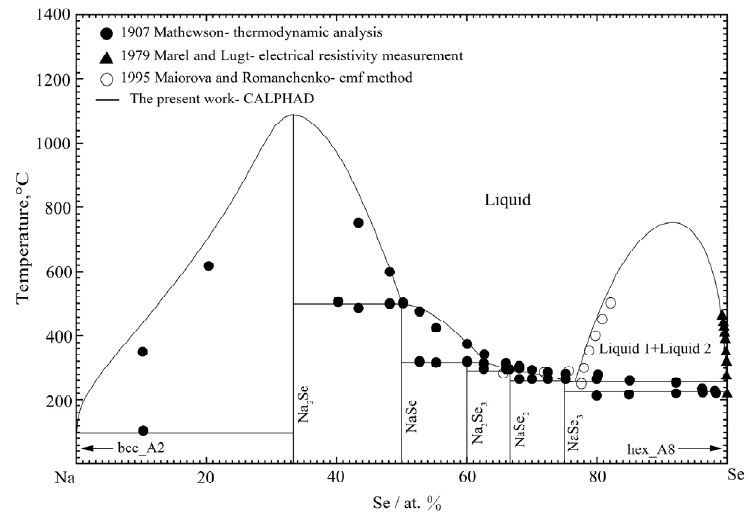
Figure 11. The calculated phase diagram of the Na-Se binary system compared with the experimental data [40,49,50].